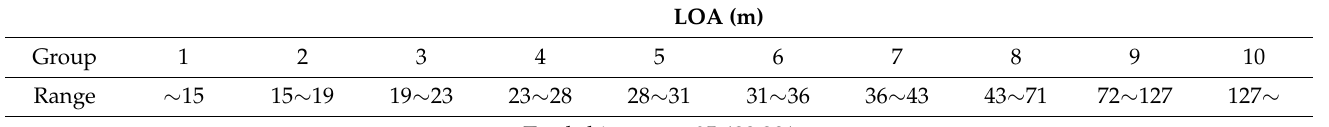
Figure 7. Distribution by LOA in Korean coastal waters.